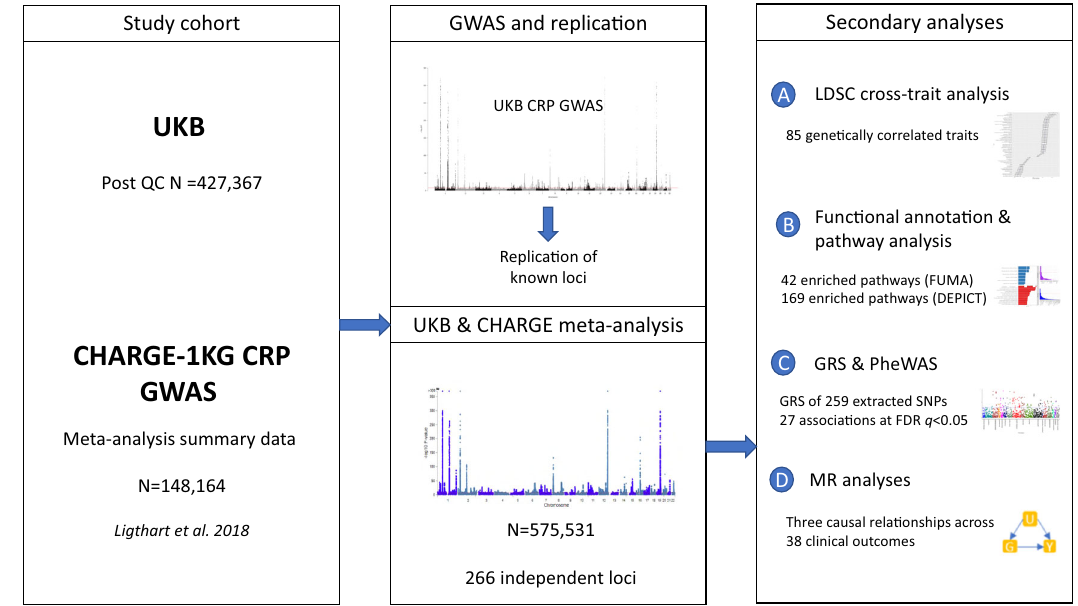
Fig. 1 Schematic overview of the study. UKB = UK BioBank, QC = quality control, 1KG = 1000 genomes, CHARGE = Cohorts for Heart and Aging Research in Genomic Epidemiology consortia, LDSC = LD score regression, FUMA = Functional Mapping and Annotation of GWAS, DEPICT = data-driven Expression Prioritised Integration for Complex Traits, GRS = genetic risk score, MR = Mendelian